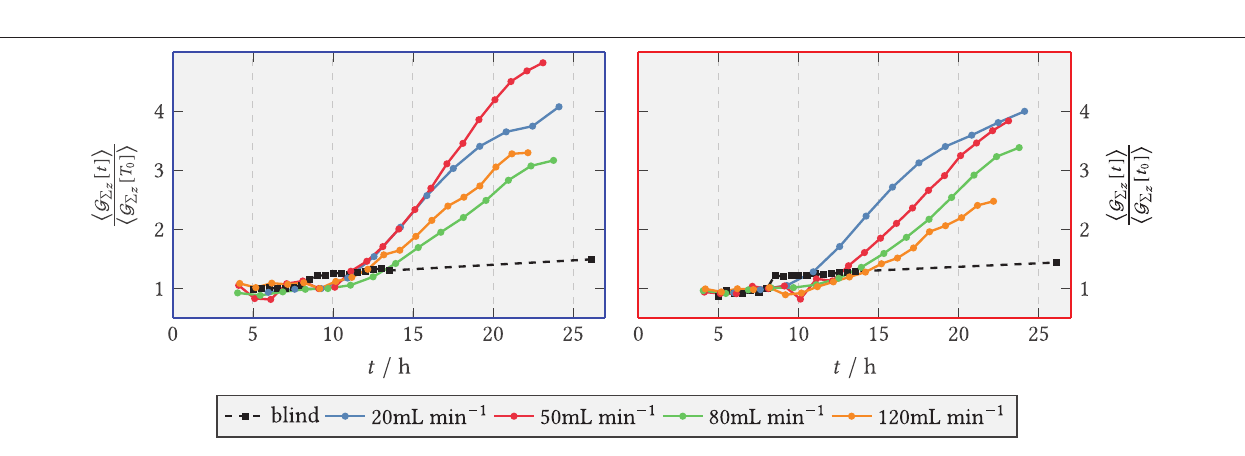
FIGURE 12 | Relative axial green fluorescence ( G ) sum of tagged secretory vesicles for ˙ V = 20,50,80,120 mL min − 1 and the blank sample (shear-free medium exchange). The fluorescence was normalized to the initial extinction at t 0 = 9 h. (Left) Zone behind the step (recirculation zone); (Right) Zone downstream of the step, x / s > 15 (after